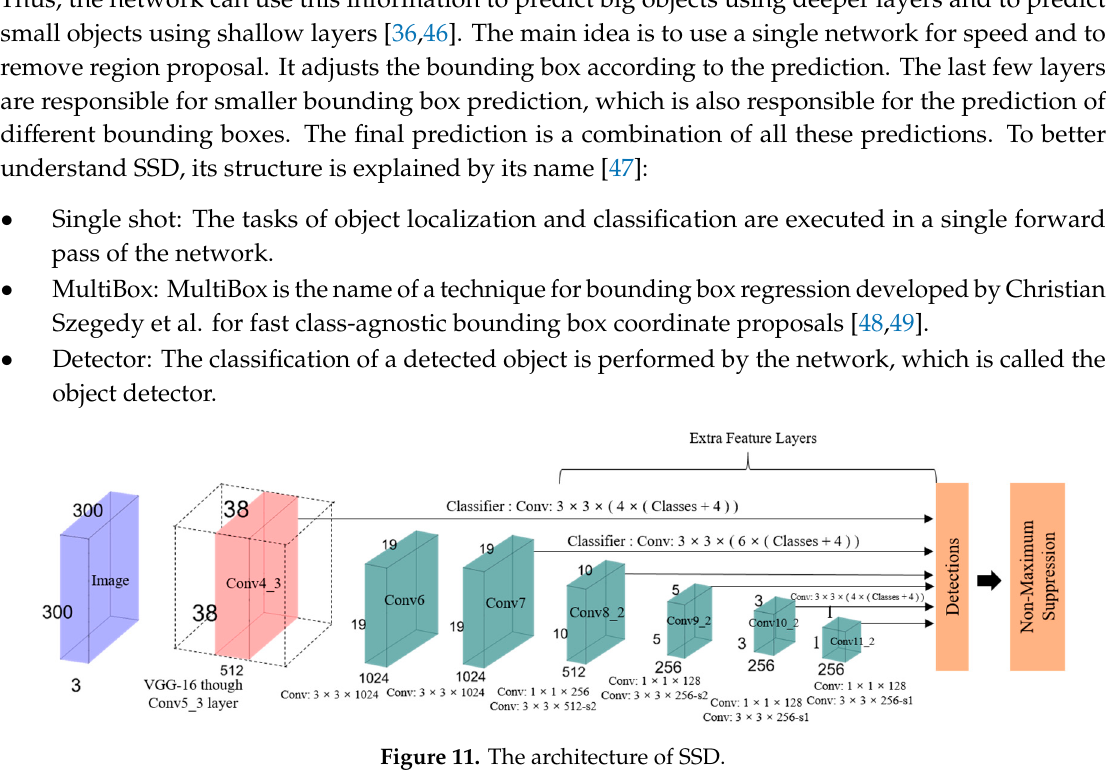
Figure 12. After creating a set of region proposals, R-CNN uses a modified version of AlexNet to determine the valid region. 3.3.1. Faster R-CNN R-CNN works really well, but is quite slow. One reason is that it requires a forward pass of the CNN (AlexNet) for every single proposed region for every single image. Another reason is that it has to train three different models separately: the CNN to generate image features, the classifier to predicts the class, and the regression model to tighten the bounding boxes [52]. Faster R-CNN adds a fully-convolutional network on top of the features of the CNN known as the region proposal network to speed up the region proposal [53]. 3.3.2. Mask R-CNN Mask R-CNN is an extended version of faster R-CNN for pixel level segmentation. Mask R-CNN [54] works by inserting a branch into faster R-CNN that adds a binary mask to determine whether a given pixel is part of an object. The branch is a fully-convolutional network on top of a CNN-based feature map [52]. Once these masks are generated, mask R-CNN amalgamates them with the classifications and bounding boxes that result from faster R-CNN. Overall, it generates precise segmentation. 3.4. DeepLab-v3 Semantic Segmentation